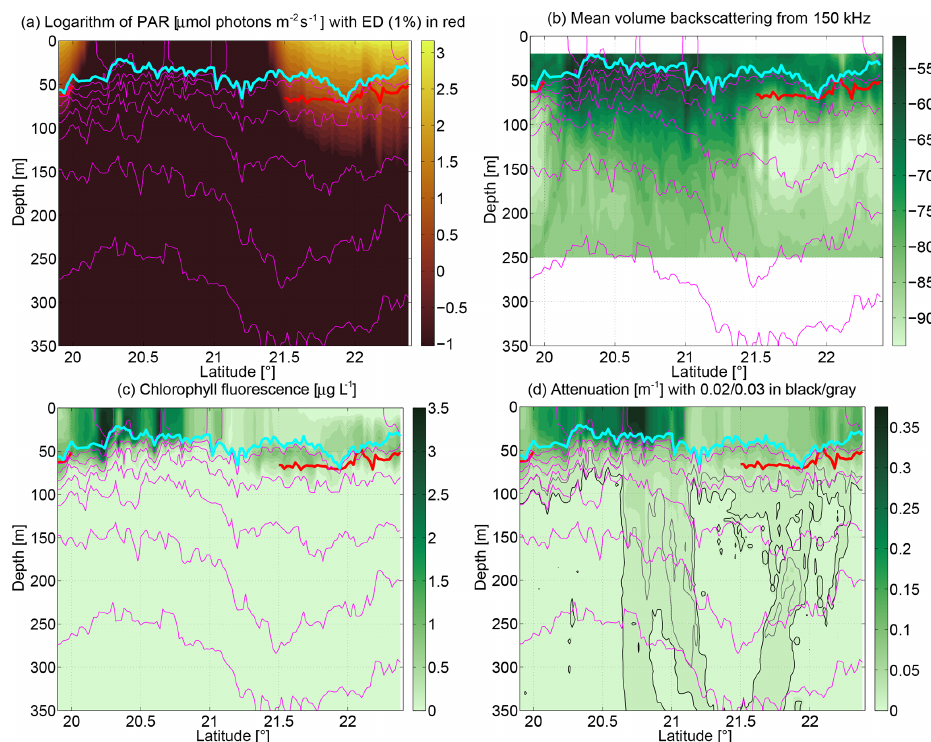
Figure 9. Sections of (a) logarithm of photosynthetically available radiation (in micromoles photons per square meter per second), (b) mean volume backscattering from 150kHz vessel-mounted ADCP (arbitrary units), (c) chlorophyll- a fluorescence from the CTD sensor (in mi- crograms per liter), and (d) light attenuation (per meter). The red line indicates the euphotic depth (1% of surface PAR). In (d) the 0.02 and 0.03m contours are indicated in black and gray,